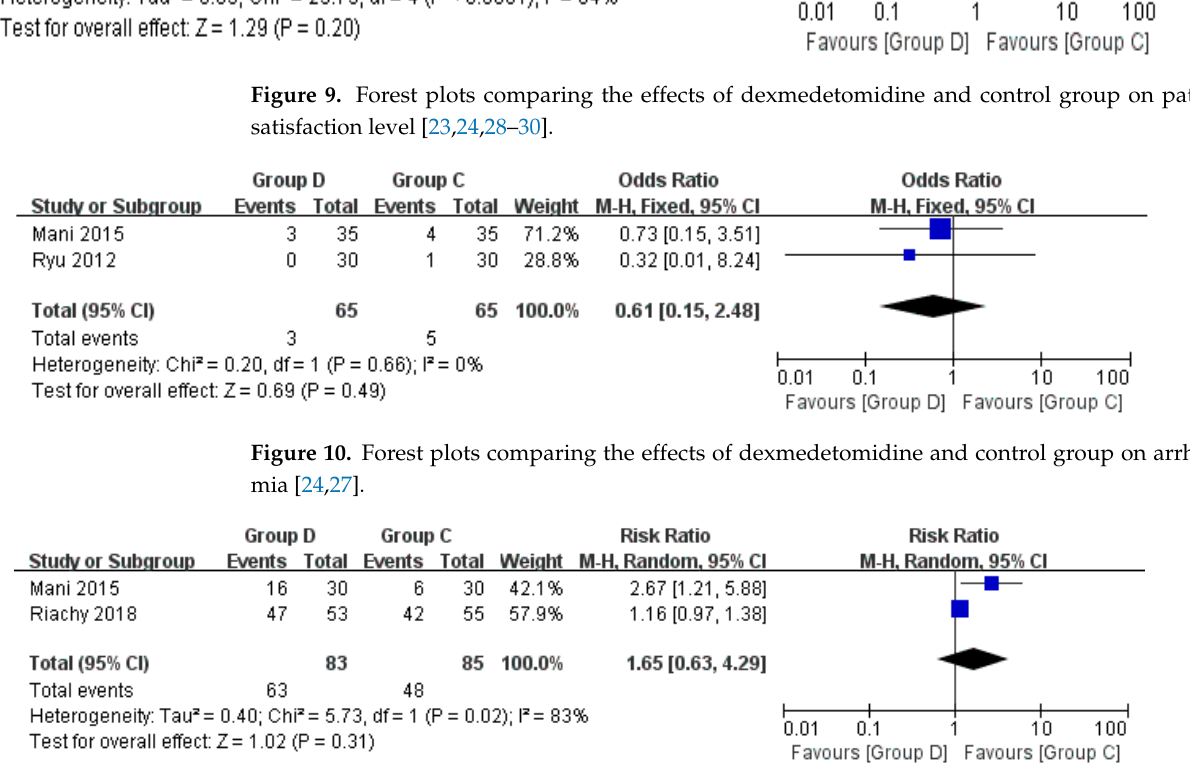
Figure 11. Forest plots comparing the effects of dexmedetomidine and control group on cough